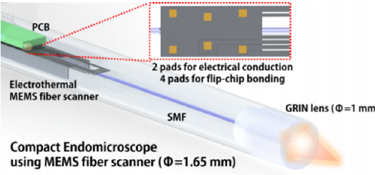
Figure 16. Schematic diagram of a thermally driven micro-electro-mechanical systems (MEMS) scanner (used with the permission of [69] © The Optical